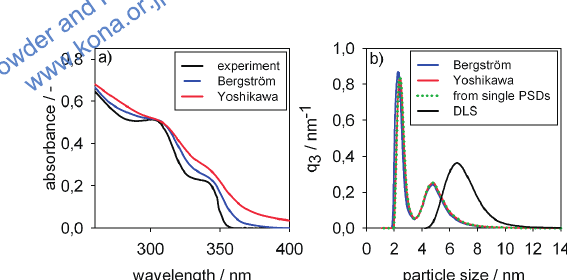
Fig. 8 a) Absorbance spectrum of the bimodal PSD after mix - ing the two suspensions in the same volume ratio (black line) and its corresponding reconstructions (blue and red lines); b) bimodal PSD calculated from the bimodal absorbance spectrum with the bulk properties from Bergström and Yoshikawa (blue and red lines), ex - pected bimodal PSD calculated from the PSDs of the pure unmixed suspensions (green dotted line), and bi - modal PSD measured with DLS (black line). Reprinted with permission from Segets et al., “Analysis of Optical Absorbance Spectra for the Determination of ZnO Nanoparticle Size Distribution, Solubility, and Surface Energy” ACS Nano 2009 3(7), p. 1703–1710. Copyright 2009 American Chemical Society.